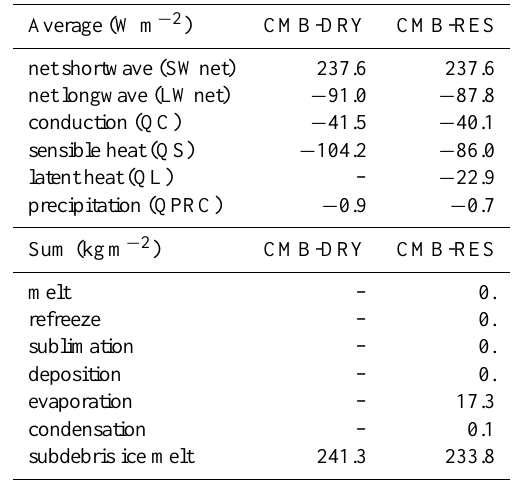
Table 4. Average-energy and accumulated-mass fluxes at the sur- face over the 2008 simulation for CMB-RES and